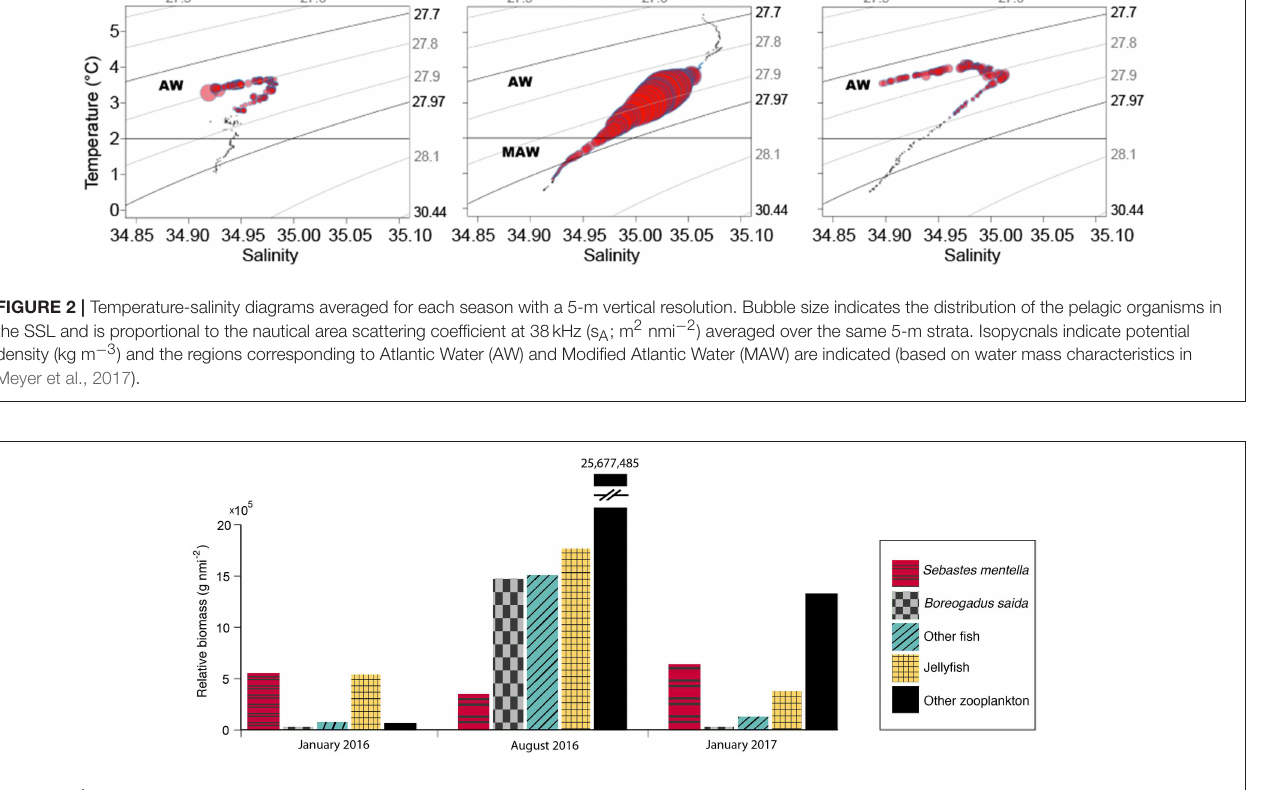
FIGURE 3 | Bar charts of the mean integrated biomass within the SSL for each